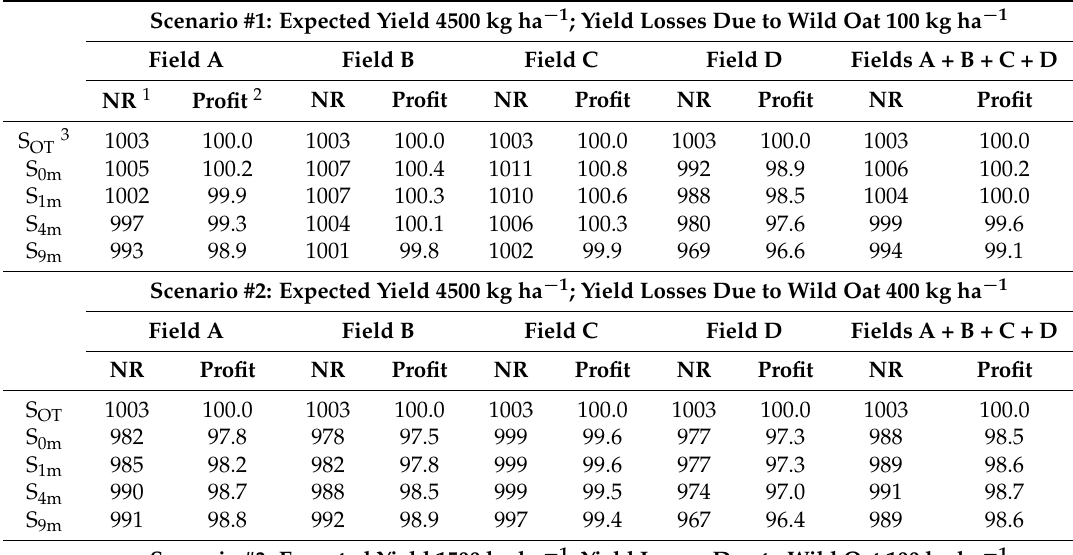
Table 4. Economic net returns and profits as a result of simulated herbicide application strategies considering different agronomic